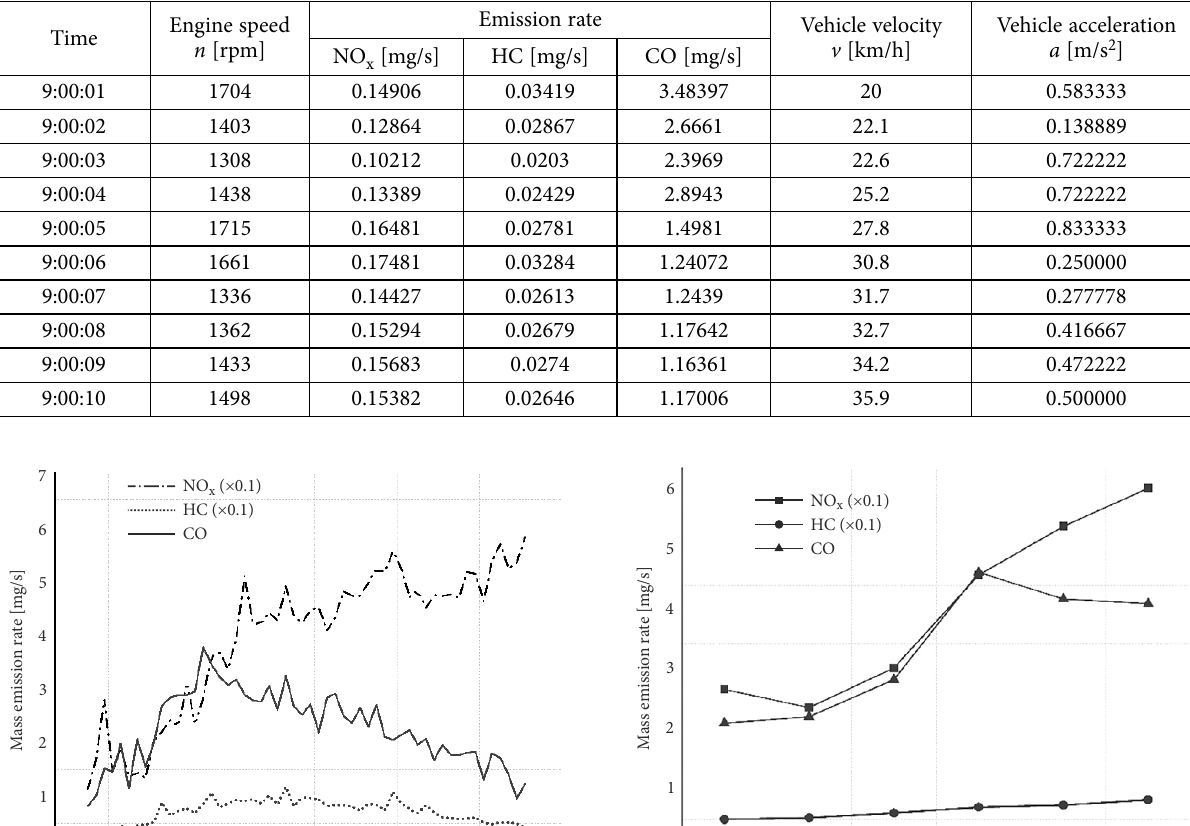
Table 2. Vehicle emission data and the corresponding driving conditions Time